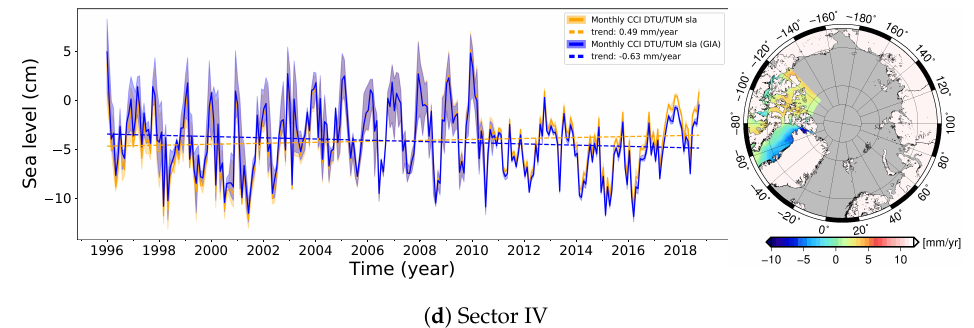
Figure 7. Regional changes of sea level in the different sectors shown in Figure 1. Blue is the monthly CCI DTU/TUM SLA in meters and the red line is the estimated trend in mm/year for the given sector. The 95% confidence level is given by the blue and yellow shadows with GIA and without GIA, respectively.